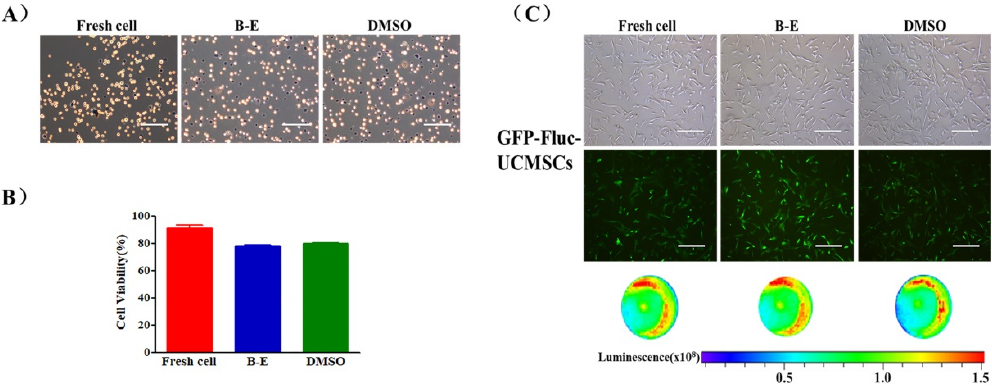
Figure 6. GFP-Fluc-UCMSCs cryopreservation by using betaine combined with electroporation. ( A ) Microscopic images of trypan blue stain (blue refers to dead cell, non-stain refers to live cell) and ( B ) quantification of survival rate of fresh and post thaw GFP-Fluc-UCMSCs. ( C ) Microscopic, fluorescence, and bioluminescence images of fresh and post-thaw GFP-Fluc-UCMSCs to characterize their morphology and expression of reporter gene (GFP and Fluc). Scale bar = 200 μ m. Value = mean ± standard deviation, n = 3.